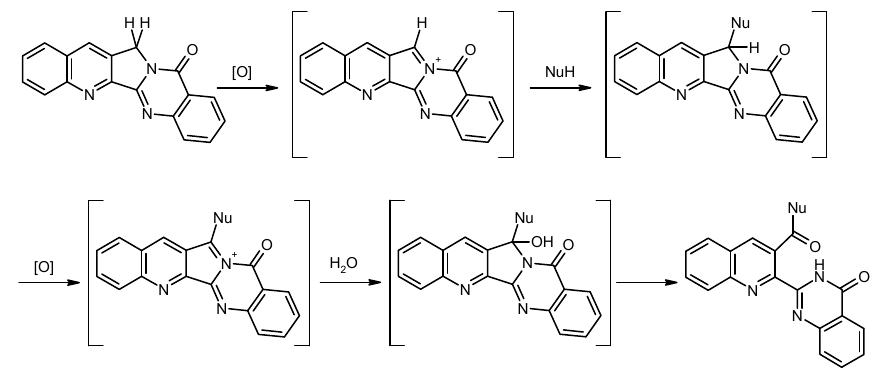
Scheme 3. Ring opening reactions of compounds 4 , 9 and 13 with various amines.